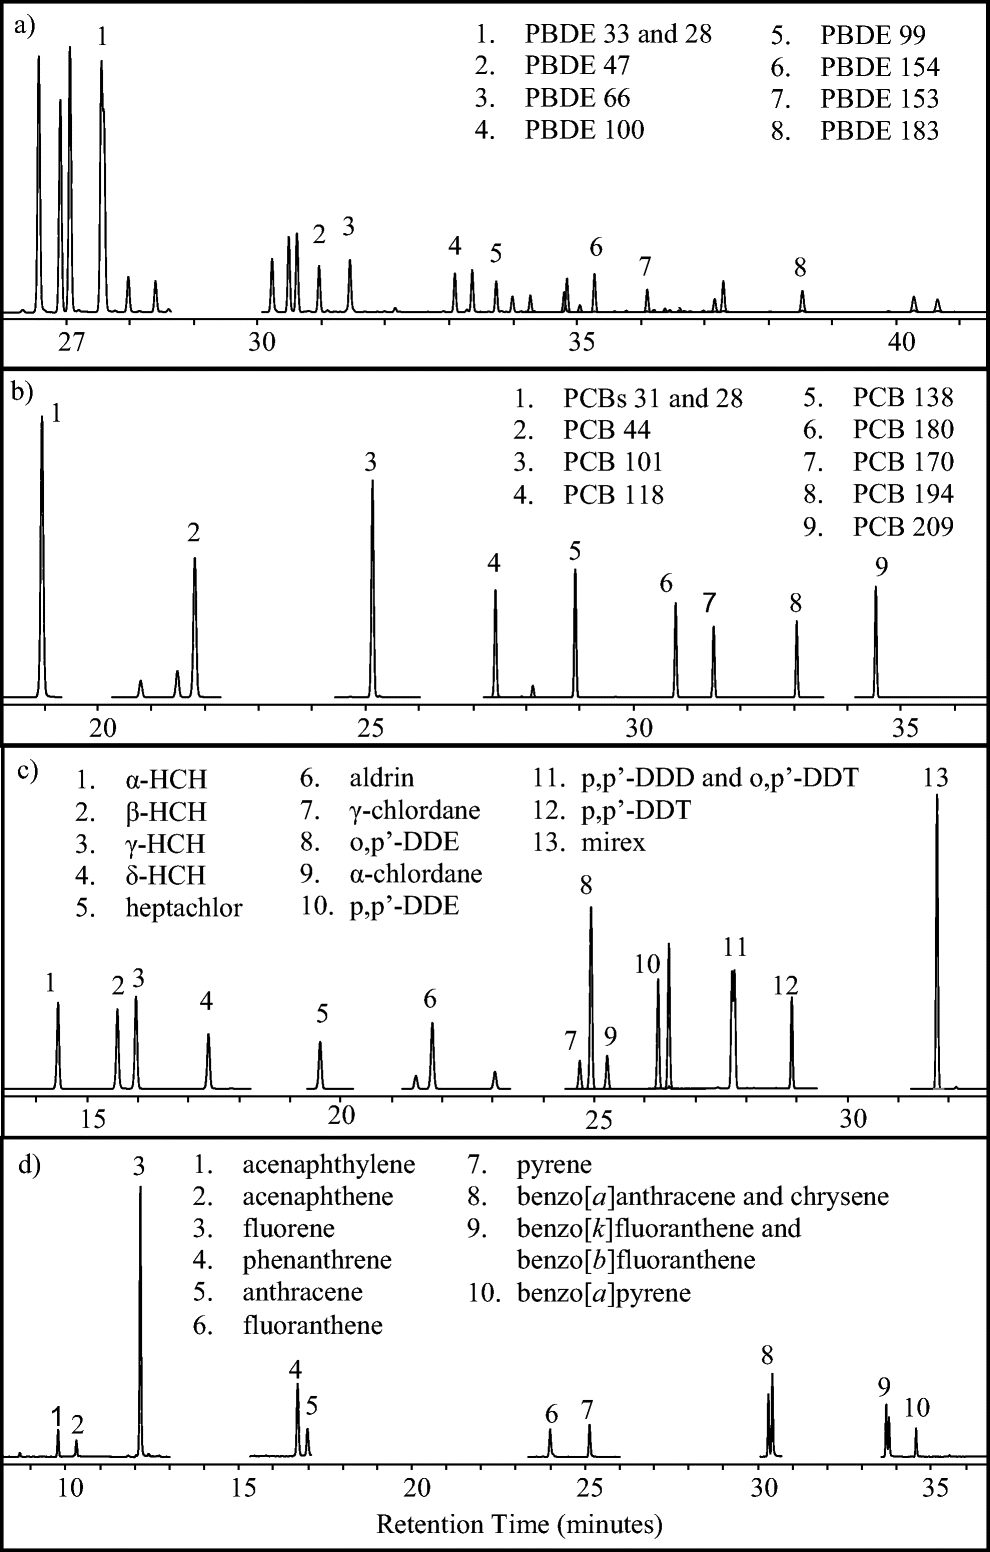
Chromatograms obtained for representative chemical classes showing area counts vs. retention time in minutes for: a) brominated flame retardants, b) polychlorinated biphenyls, c) organochlorine pesticides and their derivatives, and d) PAH). Note that, although there appear to be coeluting chemicals in chromatograms (c) and (d), these are identified by multiple reaction monitoring